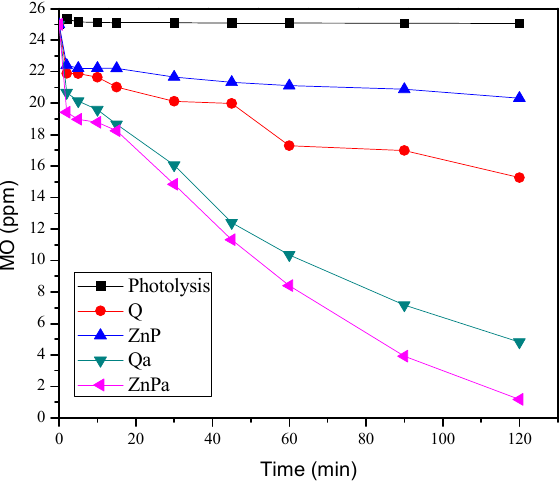
Figure 8. Evolution of the methyl orange concentration during its photodegradation over each one of the photocatalysts evaluated at different reaction time.